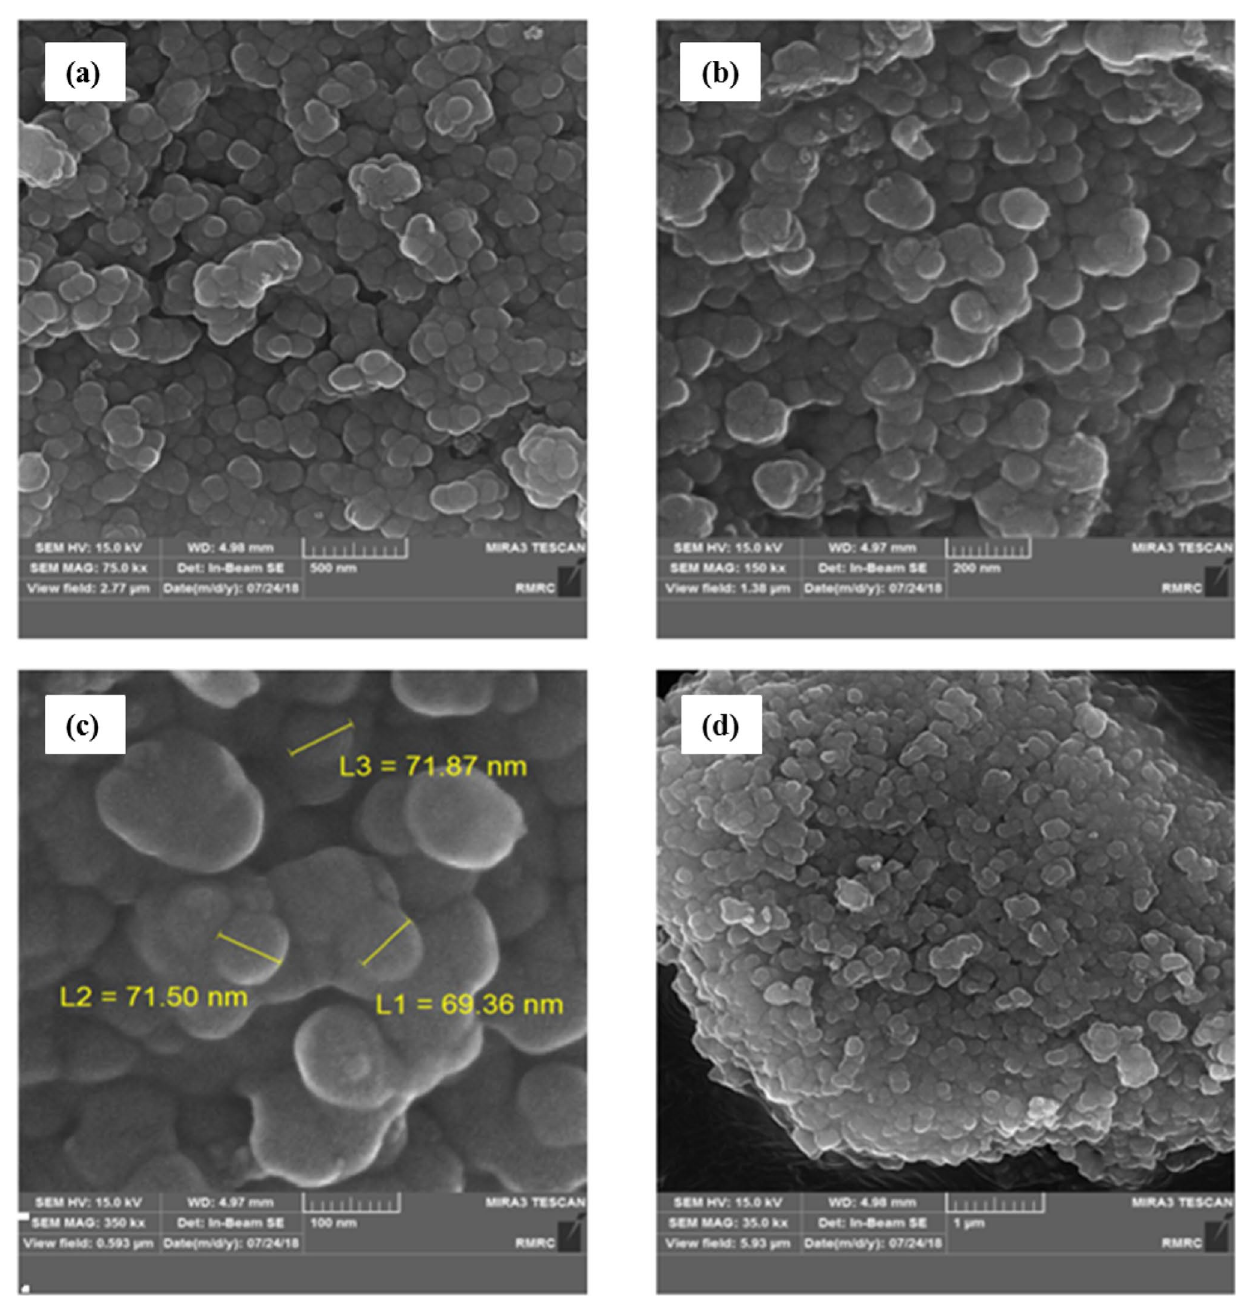
Figure 3. SEM images of Fe 3 O 4 @SiO 2 -creatine nanobiocatalyst in four different magnifications: ( a ) 500 nm, ( b ) 200 nm and ( c ) 100 nm and ( d ) 1